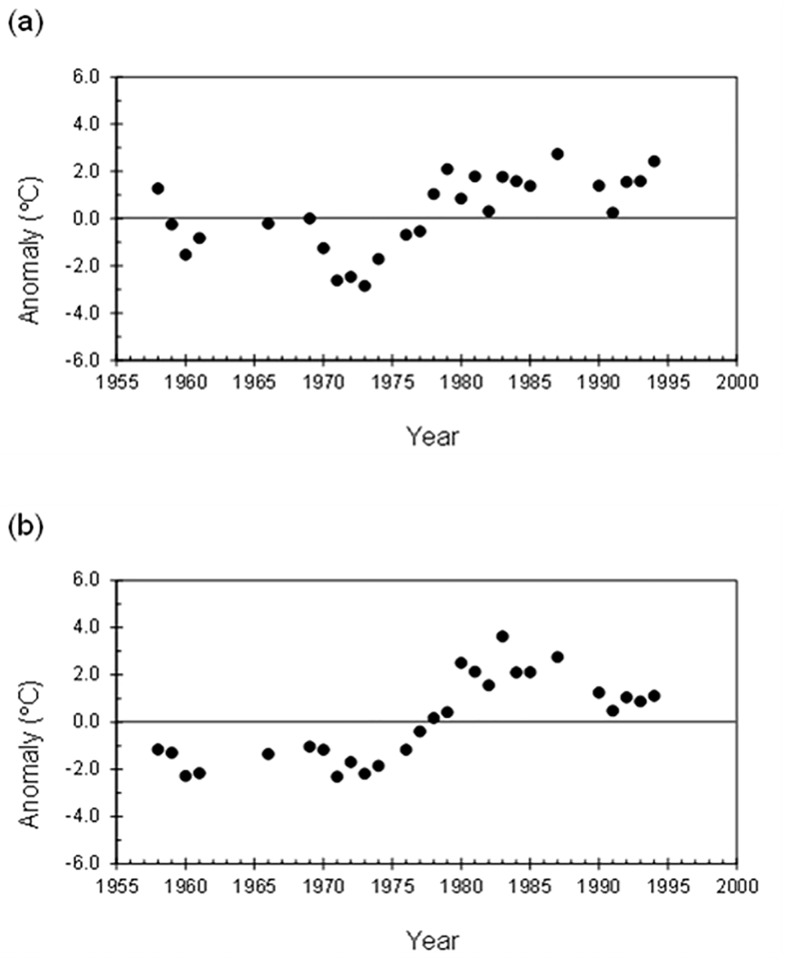
Departures from the 1961–1990 average of the annual (a) mean and (b) minimum air temperature recorded at Cedros Island.